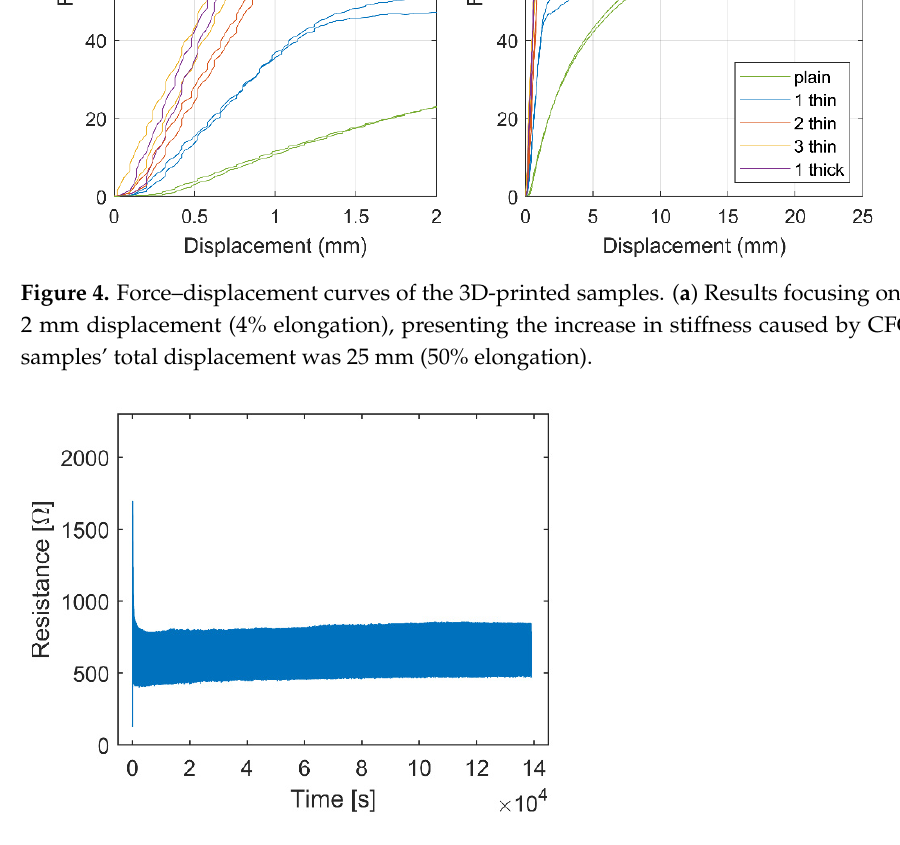
Figure 4. Force–displacement curves of the 3D ‐ printed samples. ( a ) Results focusing on the initial 2 mm displacement (4% elongation), presenting the increase in stiffness caused by CFCs, ( b ) the sam ‐ ples’ total displacement was 25 mm (50% elongation).